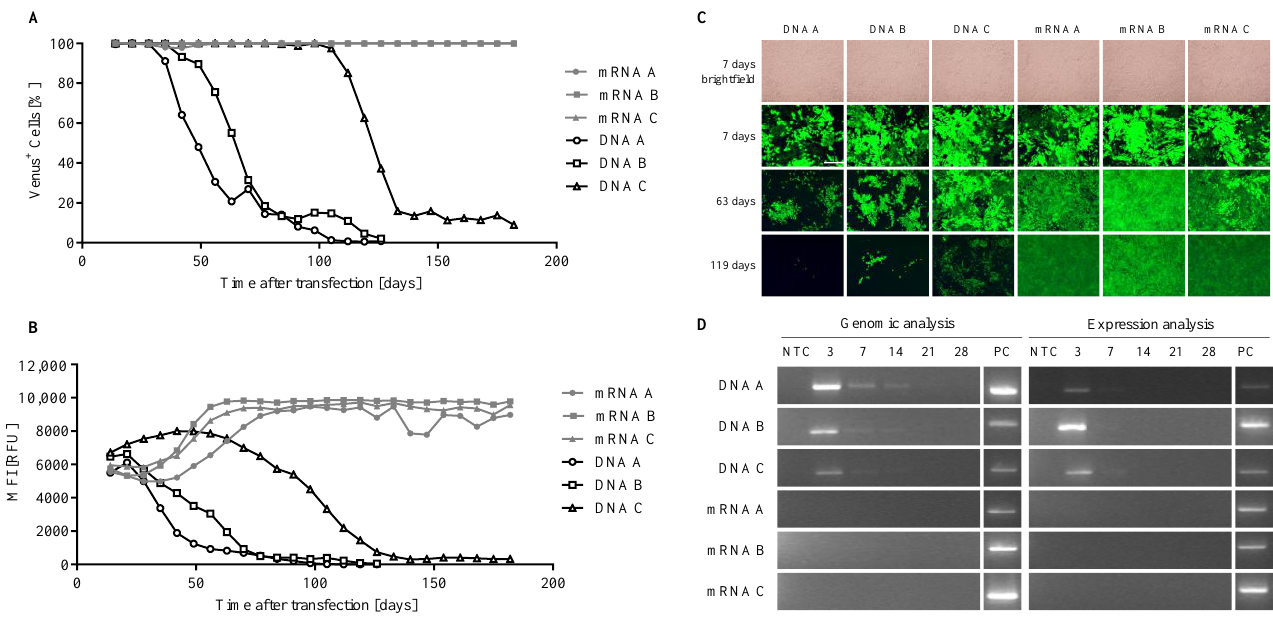
Figure 3. Expression analysis of ARPE-19 cells transfected with the pT2-CAGGS-Venus transposon plasmid together with SB100X-DNA or -mRNA. ARPE-19 cells were transfected with the pT2-CAGGS-Venus construct using SB100X-mRNA (ratio 1:16) or -DNA (ratio 1:28) and analyzed weekly by flow cytometry ( A , B ) and fluorescence microscopy (( C ), scale bar: 500 µ m) for at least 126 days. ( D ) Genomic DNA and RNA of the transfected cells were isolated at 3, 7, 14, 21, and 28 days and analyzed by PCR to detect SB100X. Samples from ARPE-19 cells transfected with pT2-CAGGS-Venus and SB100X-DNA 3 days after transfection were used as positive control (PC) for the detection of the SB100X sequence.